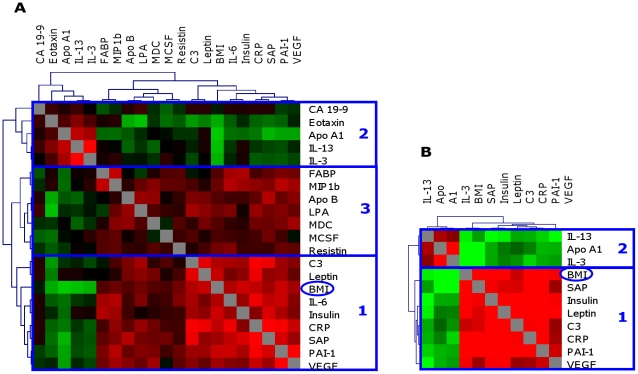
Correlation matrix of selected proteins associated with BMI in population I (A) and II (B).Correlation coefficients are displayed on a color scale, ranging from −0.6 (green) to 0.6 (red). For population I (A) 20 proteins selected by RF to be associated with BMI are included. This group of proteins was divided in three clusters based on similarity in the association with BMI and with each other. For population II (B) 10 proteins selected by RF and also associated with BMI in population I are included. This group of proteins was divided in two clusters based on similarity in the association with BMI and with each other. Abbreviations: Cancer Antigen 19-9 (CA 19-9), Apolipoprotein A1 (ApoA1), Fatty Acid Binding Protein (FABP), Macrophage Inflammatory Protein-1 beta (MIP1b), Apolipoprotein B (ApoB), Lipoprotein A (LPA), Macrophage Derived Chemokine (MDC), Macrophage colony-stimulating factor (MCSF), Complement 3 (C3), C Reactive Protein (CRP), Serum Amyloid P (SAP), Plasminogen Activator Inhibitor-1 (PAI-1), Vascular endothelial growth factor (VEGF).